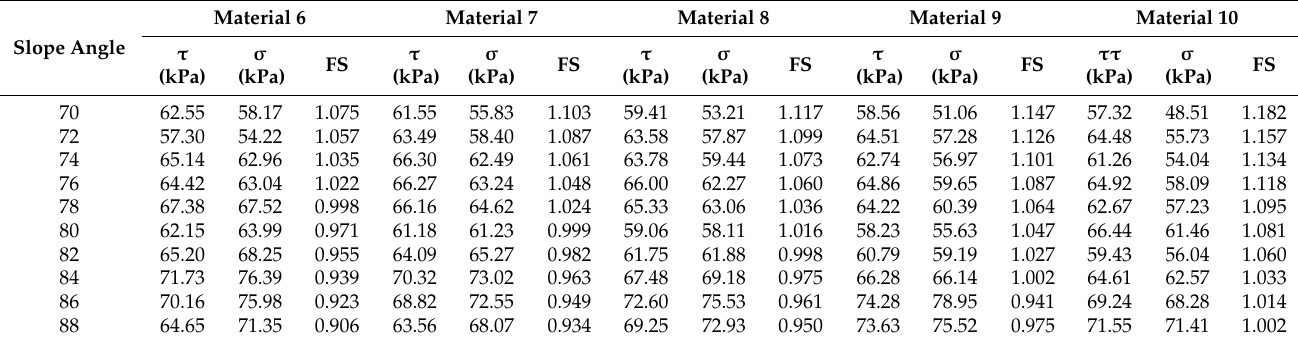
Table 6. τ and σ in the case of an unsaturated seismic analysis—Materials 6 to 10.